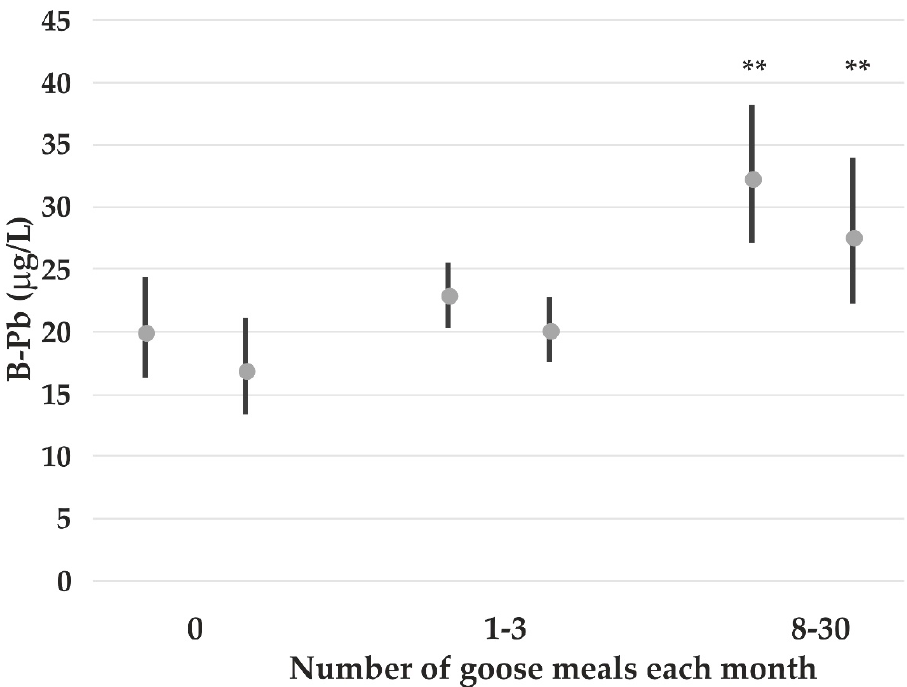
Figure 6. GM (and 95% CI) B-Pb concentrations among all participants (left) and non-hunters (right) according to number of meals with goose meat/month. The p -values (** p < 0.01) refer to comparisons between groups with no consumption of goose and the other respective subgroups.